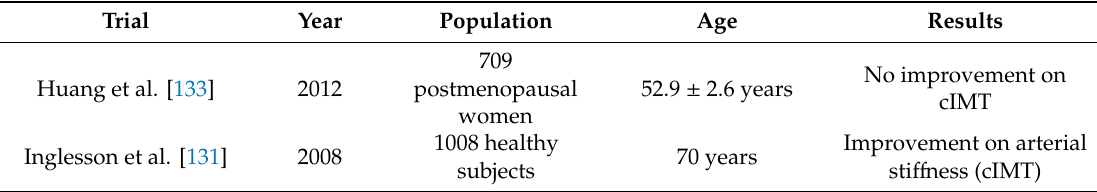
Table 4. E ff ects of vitamin A supplementation on subclinical atherosclerosis in patients without manifest